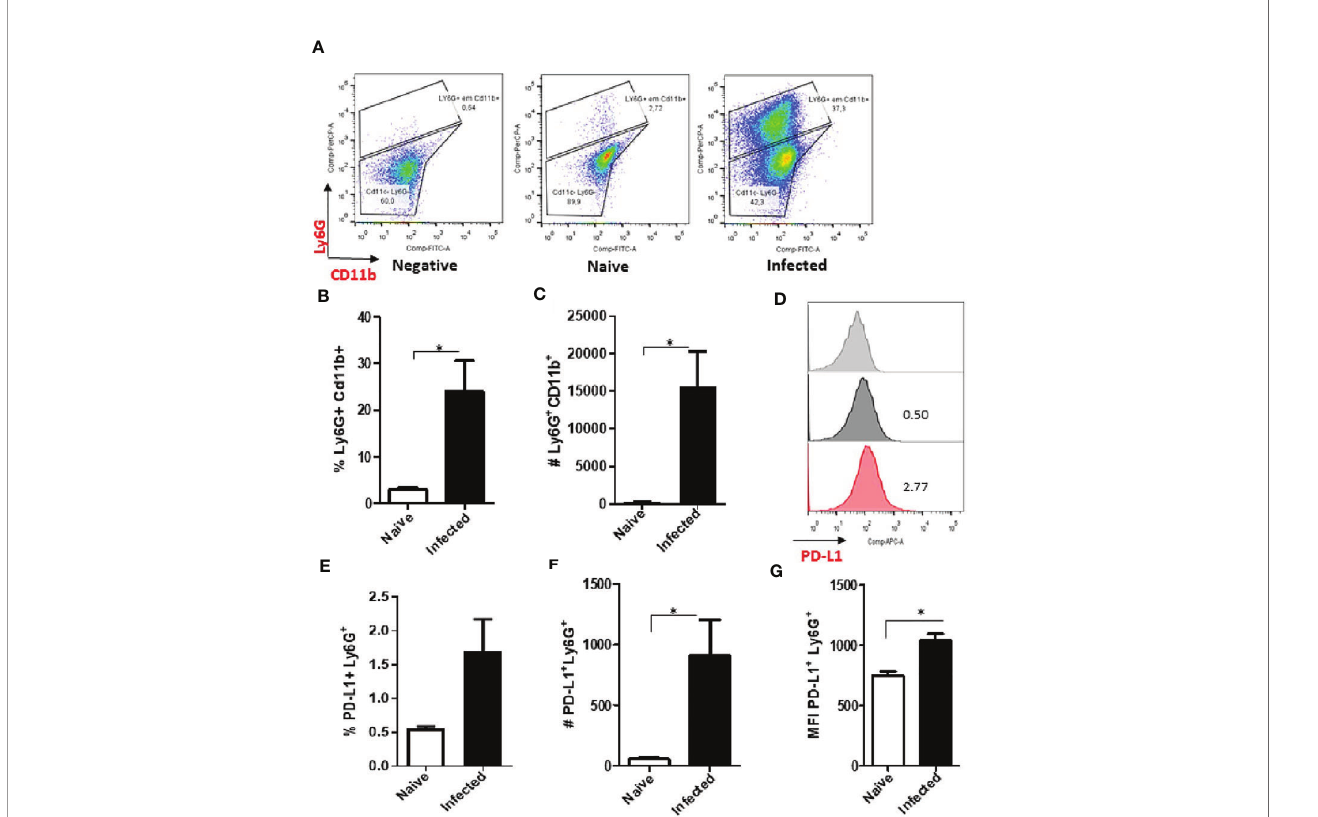
FIGURE 4 | Increase of PD-L1 + Ly6G + cells in L. amazonensis -infected ear lesions. Cells were collected from L. amazonensis -infected mouse ears after around 50 days. Controls were performed with uninfected mice (naïve). (A) Dot plot showing Ly6G + CD11b + cells (Ly6G-PerCP, CD11b-FITC). (B) Percentage of Ly6G + CD11b + cells. (C) Number of Ly6G + CD11b + cells. (D) Histogram of PD-L1 expression. Grey = Fluorescence minus one control (FMO) for PD-L1, Dark grey = Naïve and Red = Infected ear cells. (E) Percentage of PD-L1 + Ly6G + cells, p=0.057. (F) Number of PD-L1 + Ly6G + cells. (G) MFI of PD-L1 + Ly6G + . Data are mean ± SEM from two independent experiments (7-8 mice/group). *p <